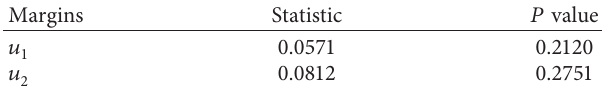
Table 8: Uniformity test on the interval [0, 1].